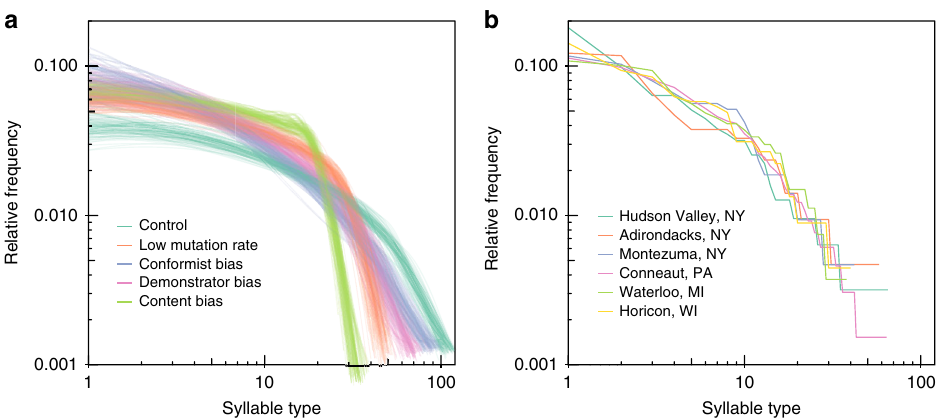
Fig. 2 Simulated and empirical syllable type frequencies. a Frequency distributions of syllable types found in simulations with different types of bias, illustrating how different aspects of individual learning in fl uence population-levels of diversity. A total of 100 simulations were carried out for each of 6 conditions. In the Control case, individuals had a mutation rate of 0.01 and no bias to learning. In the Low-mutation rate condition, μ = 0.001. In the Demonstrator Bias simulations, v = 2. In the Content Bias simulations, p att = 0.1. In the Conformist Bias simulations, α = 1.2. b Frequency distributions of syllable types found in the empirical data set, from the 6 populations sampled (Conneaut, n = 208, Montezuma, n = 71, Adirondacks, n = 70, Waterloo, n = 74, Horicon, n = 91, Hudson Valley, n = 101), illustrating the consistency found between populations and suggesting a match between the empirical data and the simulations with Conformist